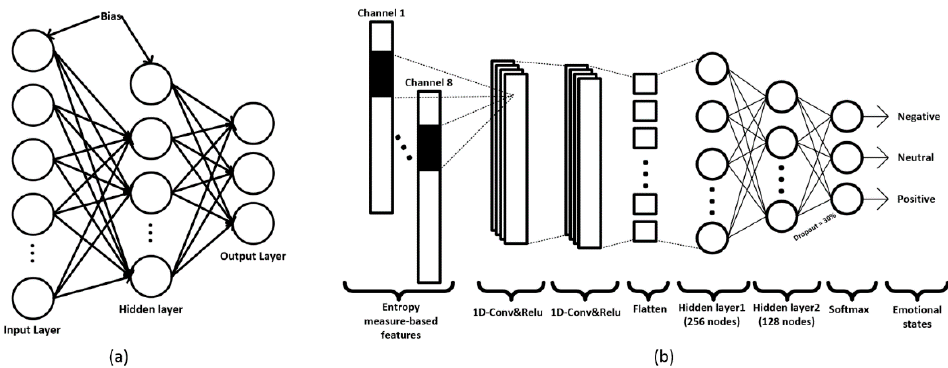
Figure 5. ( a ) The proposed MLP model; ( b ) the proposed 1D-CNN model.